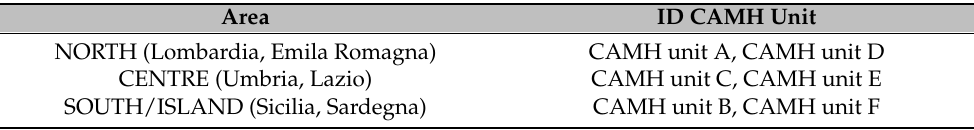
Table 1. Geographical distribution of the selected CAMH units.